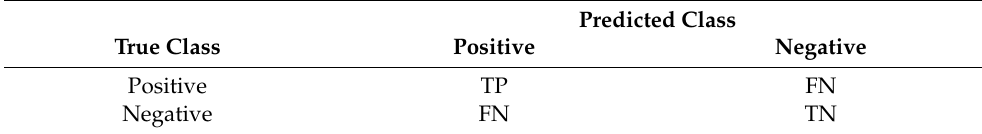
Table 4. A typical Confusion Matrix.